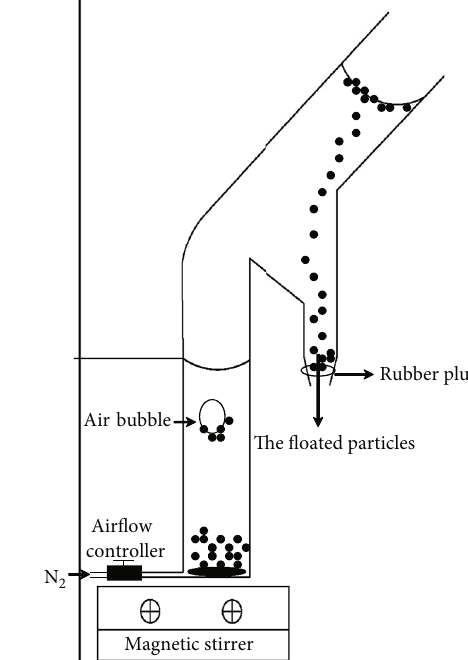
Figure 4: Schematic of the Hallimond tube used in the fl otation